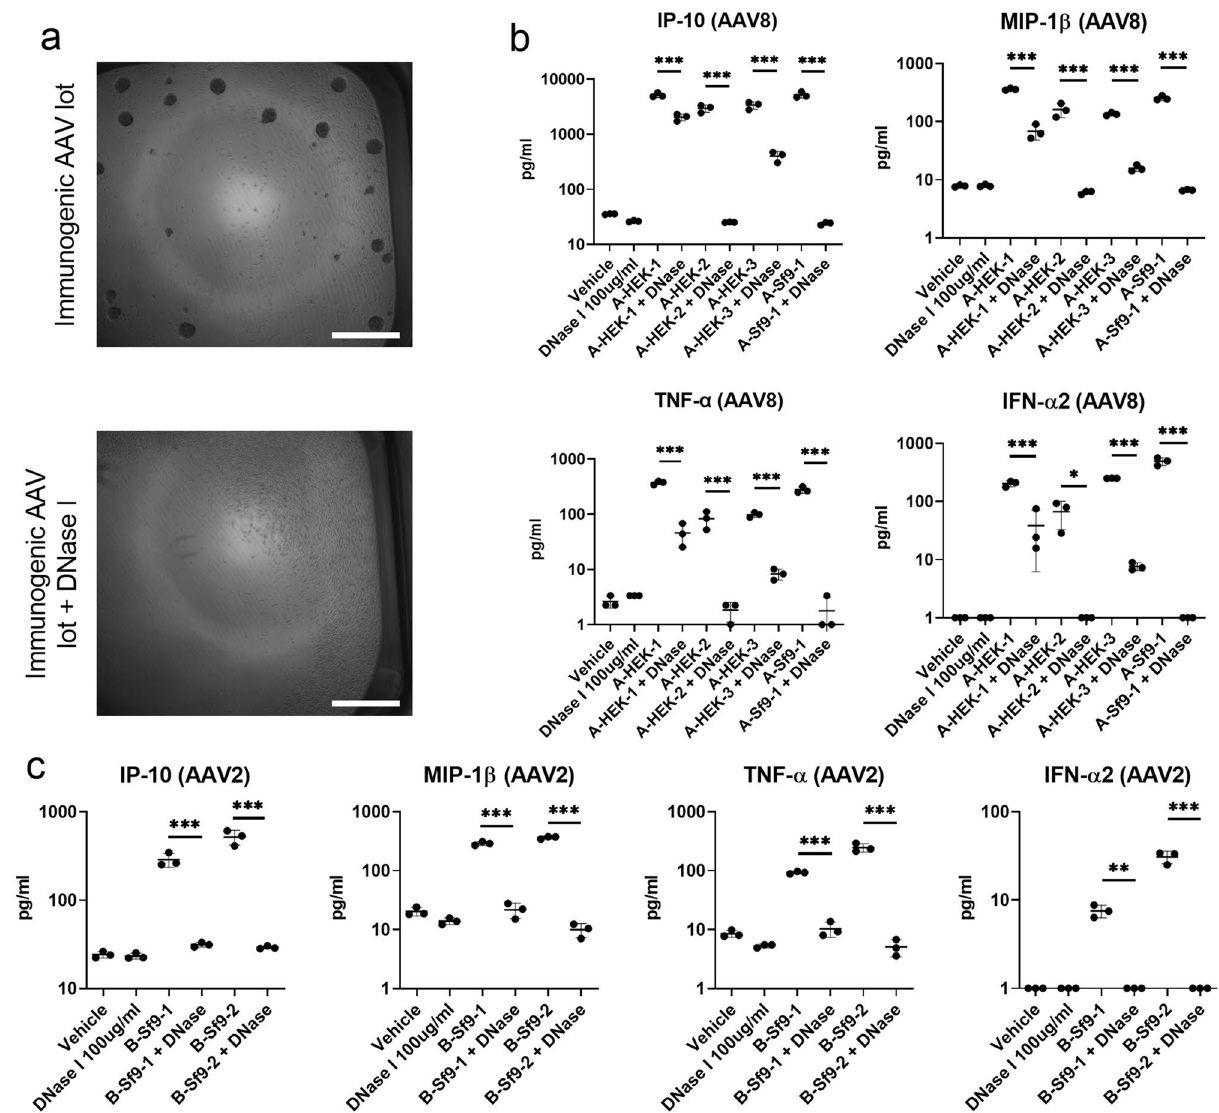
Figure 4. DNase pre-treatment reduces immune responses induced by “immunogenic” AAV8-CMV-eGFP and AAV2-CMV-eGFP vector lots. Human pDCs were stimulated with DNase-treated “immunogenic” AAV8 vector lots for 18 h (MOI: 1:1 × 10 6 vg). ( a ) Representative bright field images of purified pDCs stimulated with “immunogenic” AAV vector lots ( upper image ) and “immunogenic” AAV vector lots pre-treated with 100 μg/ ml of DNase I ( lower image ). Scale bar is 500 μm. ( b ) Cytokine release of IP-10, MIP-1β, TNF-α and IFN-α2 by AAV8-stimulated pDCs. ( c ) Cytokine release by AAV2-stimulated pDCs. Since in the IFN-α2 measurements ( b and c ) and TNF-α measurement ( b ) some values fell below the assay range, the constant 1 was added to all measured IFN-α2 and TNF-α values for presentation in a semi-logarithmic plot. Shown are means and standard deviations. Statistical significance was determined using one-way ANOVA and Holm–Sidak’s post hoc analysis. P values: ≤ 0.05: *; ≤ 0.01: **; ≤ 0.001: